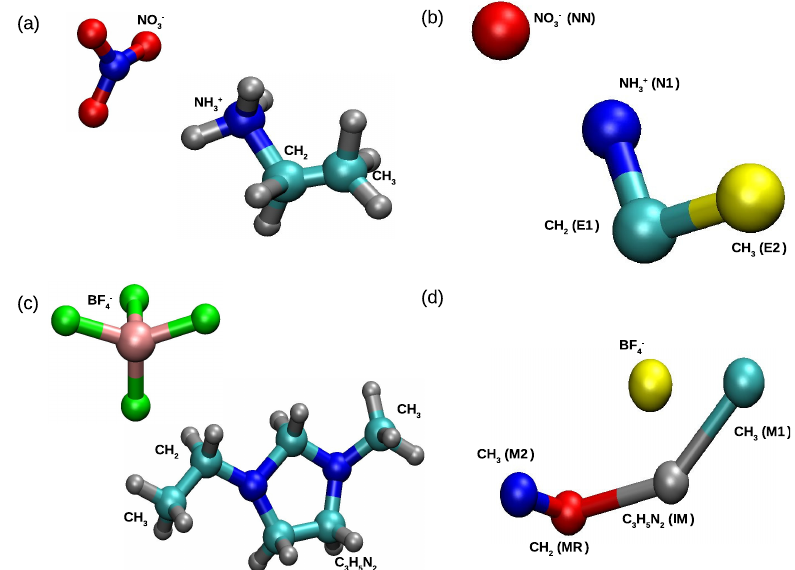
Figure 1. All atom models of ethylammonium nitrate (EAN) and 1-ethyl-3-methylimidazolium tetrafluoroborate (EMIM-BF 4 ) are shown in ( a , b ), and their respective coarse-grained models are shown in ( c , d ). All-atom model colors are: C (teal), H (silver), N (blue) and O (red). All-atom EAN and EMIM-BF 4 ion-pairs are approximately 5.0 and 10.0 Å across in